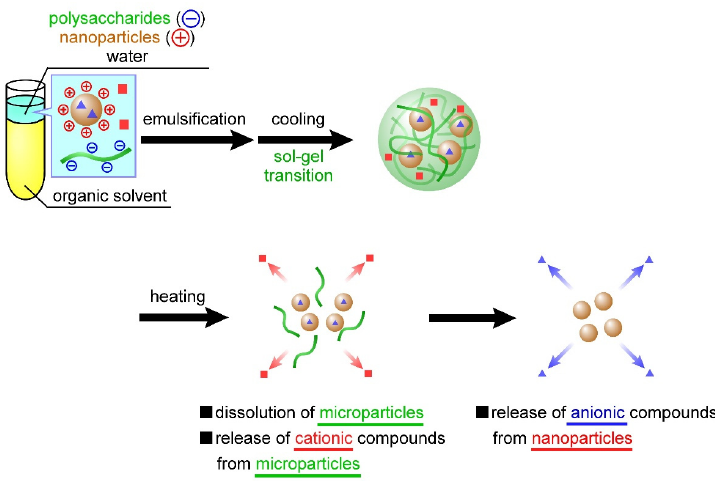
Figure 1. Temperature-responsive nanoparticle-containing or nanoparticle-decorated polysaccharide microparticles for the release of multiple compounds. The nanoparticles and compounds (red squares) dispersed inside the microparticles are released in a temperature-responsive manner, followed by the release of another compound (blue squares) from within the nanoparticles.